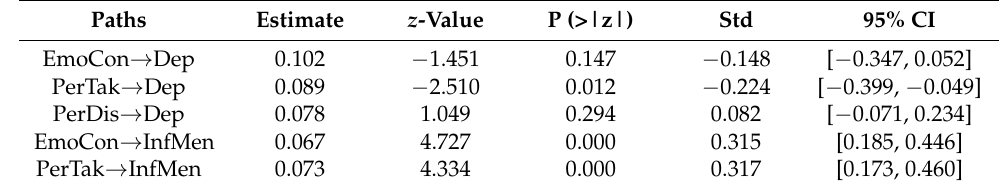
Table A3. Multiple mediation analyses for direct effect from dimensions of empathy to depersonal- ization through the inference of mental